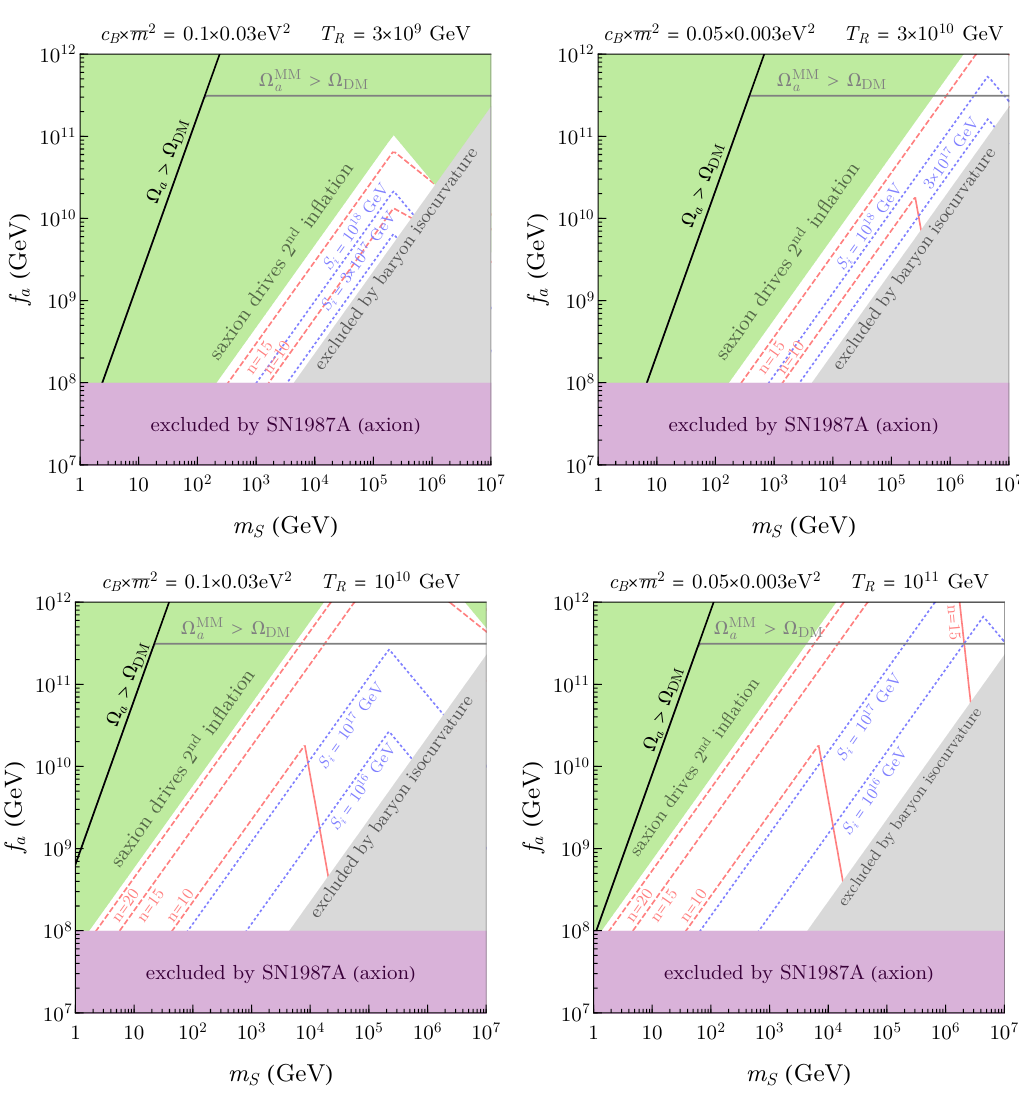
Figure 4 . Parameter space compatible with the observed baryon asymmetry for the quartic po- tential for N DW = 1 . Here the production of Y B is dominated during inflationary reheating with a different reheat temperature for each panel. Left (right) panels are for larger (smaller) c B ¯ m 2 as labeled. We fix (cid:15) = 0 . 125 , which affects the black and pink solid lines. bound on T from successful thermal leptogenesis from right-handed neutrinos [36, 75, R